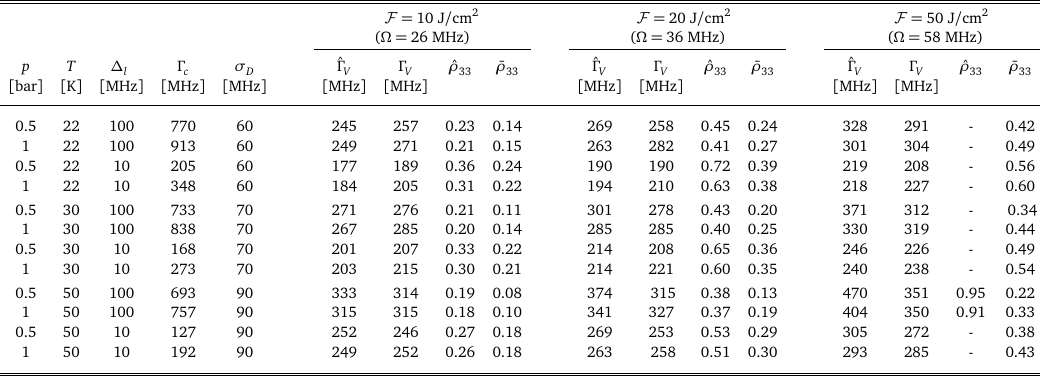
Table 7: Same as Table 4 but for a laser exposure time of τ = 10